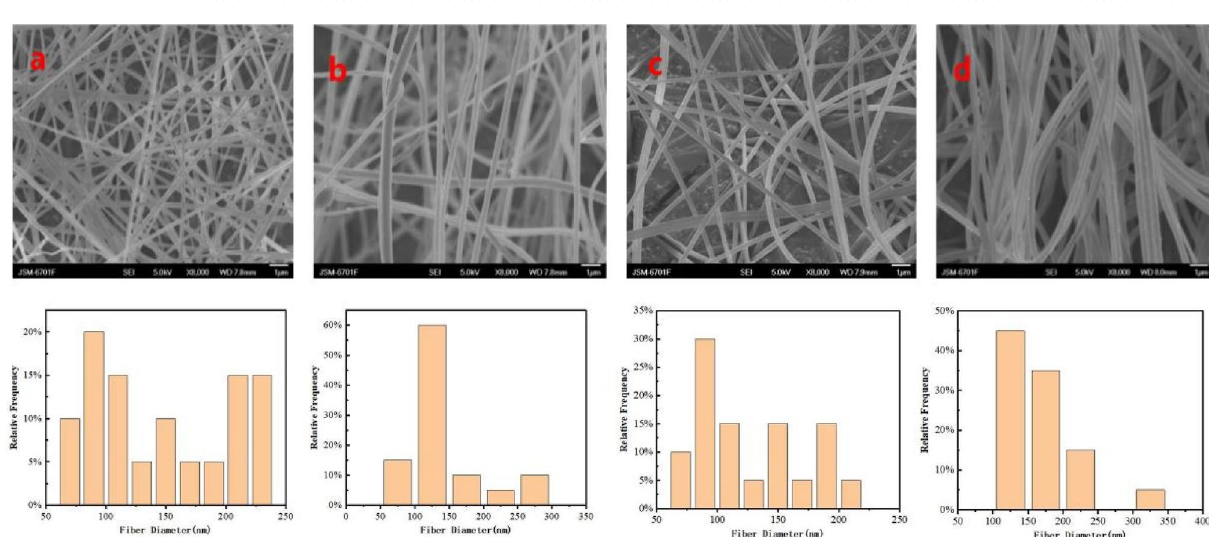
Figure 5. SEM images of electrospun CMKN fibers at different collection distances and fiber diameter distribution (( a ):10 cm; ( b ):15 cm; ( c ):20 cm; ( d ):25